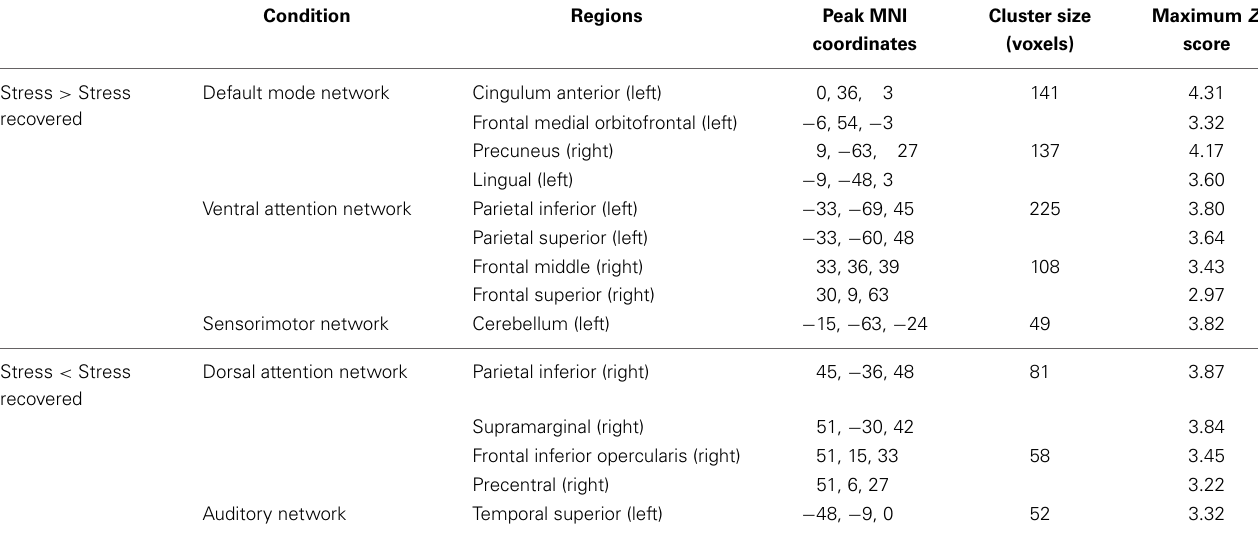
Table 1 | Group differences (Stress vs. Stress recovered) at rest, in brain regions of the DMN, VAN, SMN, DAN, and AN maps (paired t -tests, corrected for multiple comparisons, p < 0 . 05). Condition Regions Peak MNI Cluster size Maximum Z coordinates (voxels)